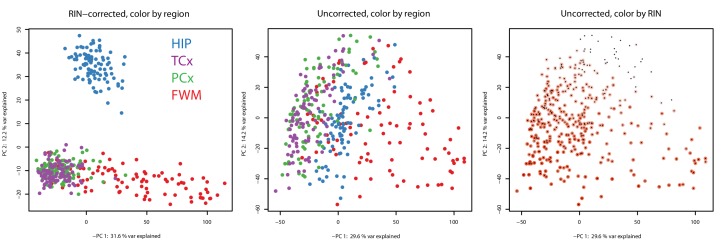
Decreased separation of brain region in principal component space without RIN correction.(Left) Principal component analysis (PCA) of all samples in this data set using RIN-corrected data separates cortical grey vs. white matter (PC 1, x-axis) and hippocampus from cortex (PC 2, y-axis). First two PCs are shown and explain 43.8% of the variation. PCA groups samples by brain region (color), except for temporal and parietal grey matter, which completely overlap. (Center) Repeating the PCA on unnormalized data identifies one component related to brain region (PC 1) and a second component related to RNA quality (PC 2). Dots correspond to samples. Colors correspond to brain regions. (Right) Same plot as the center, but coloring each dot by RIN (white = low RIN, red = high RIN). *Included as separate files.